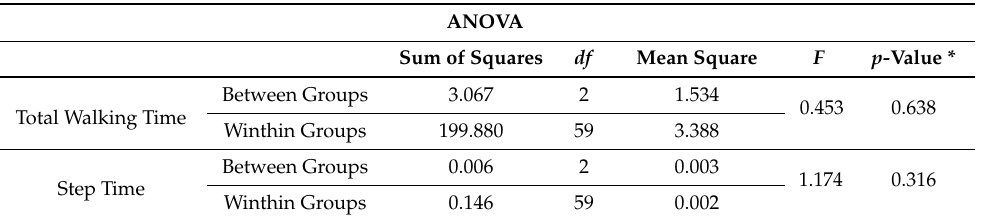
Figure 8. Results of 10-m straight-line walking: ( a ) average step time; and ( b ) total walking time. Table 2. ANOVA test of 10-m straight-line level walking for three groups.